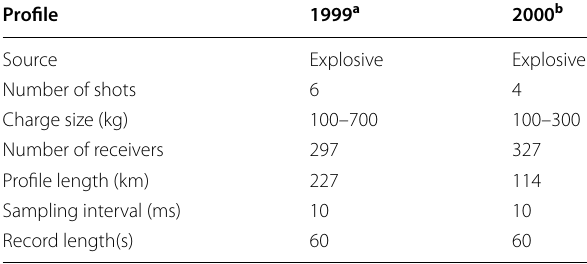
Table 2 Seismic refraction/wide-angle